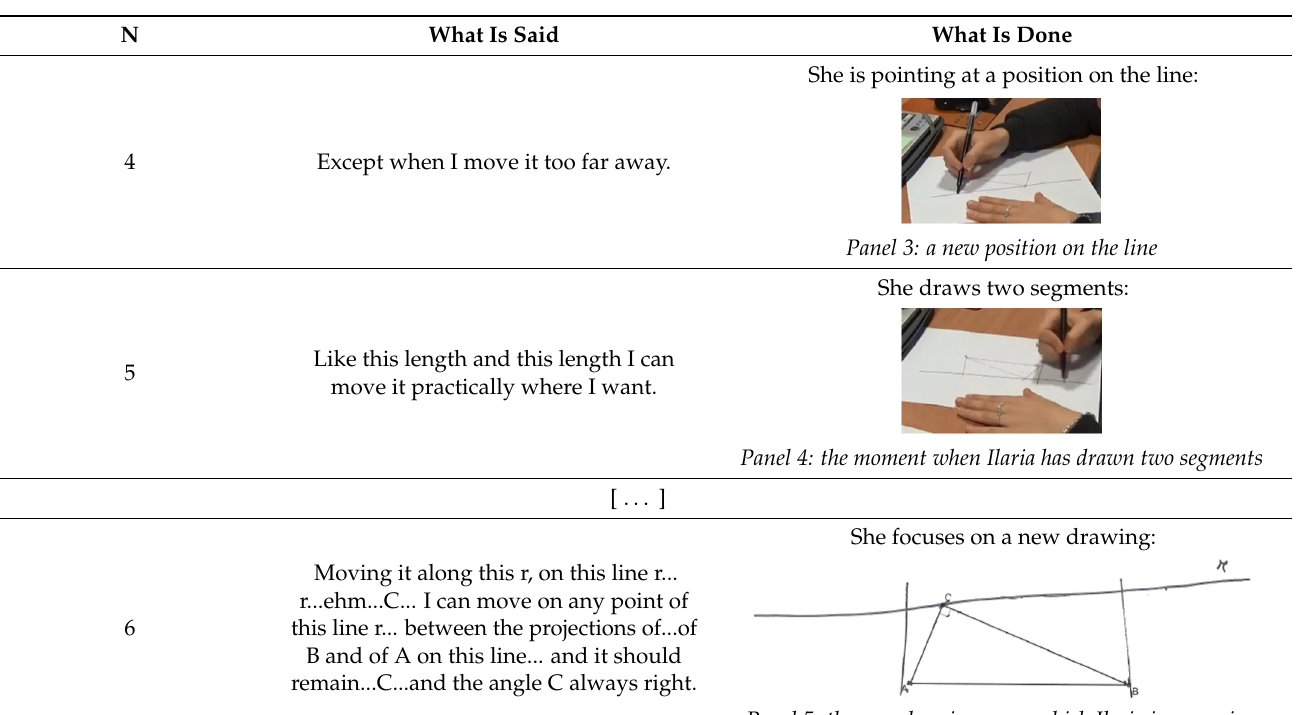
Table 3. Excerpt 2 from Ilaria’s interview.